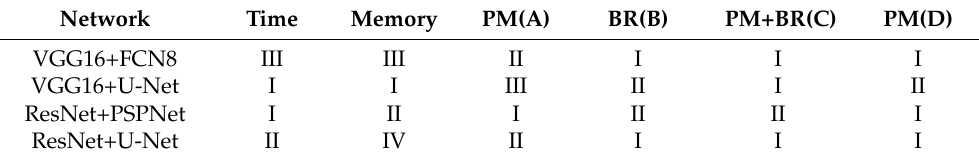
Table 11. Ranking for every network at a given metric. The experiment is indicated in parenthesis.